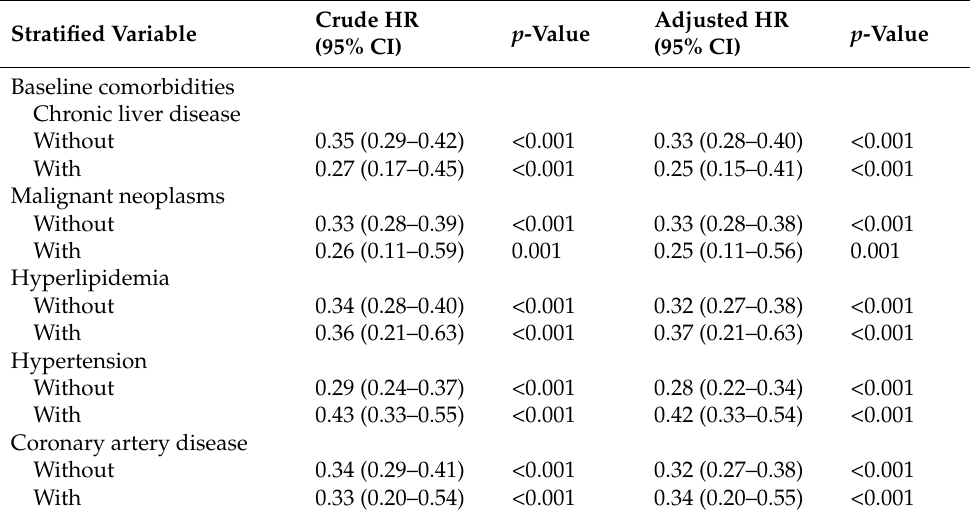
Table 4. Subgroup analysis of the association between administration of non-steroidal anti- inflammatory drugs and risk of type 2 diabetes mellitus on the basis of baseline